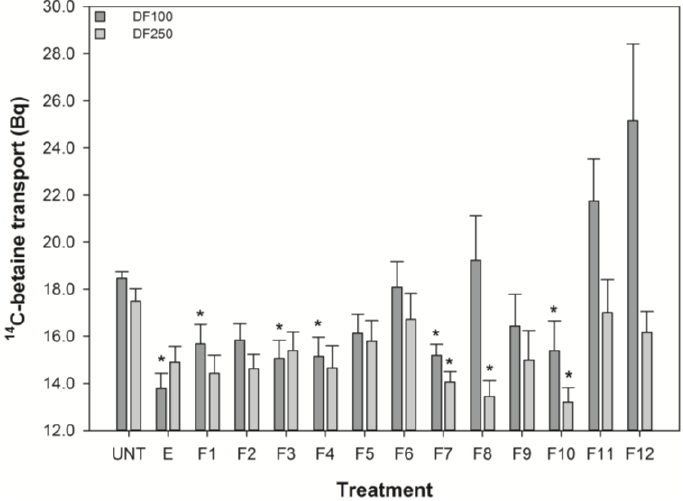
Figure 2. The effect of turmeric on 14 C-Betaine transport by the SLC22A4 503F variant. DF refers to dilution factor and a value lower than the untreated (UNT) indicates reduced transport. The data are expressed as the mean (±SEM) of twelve independent replicates. A statistical difference between untreated and treated cells is indicated by * p <